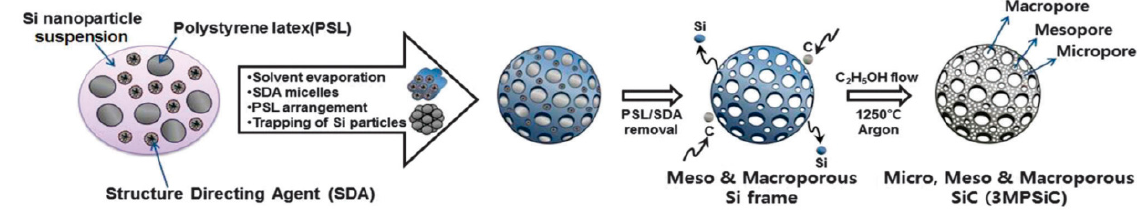
Figure 9. Schematic representation showing overall synthesis process